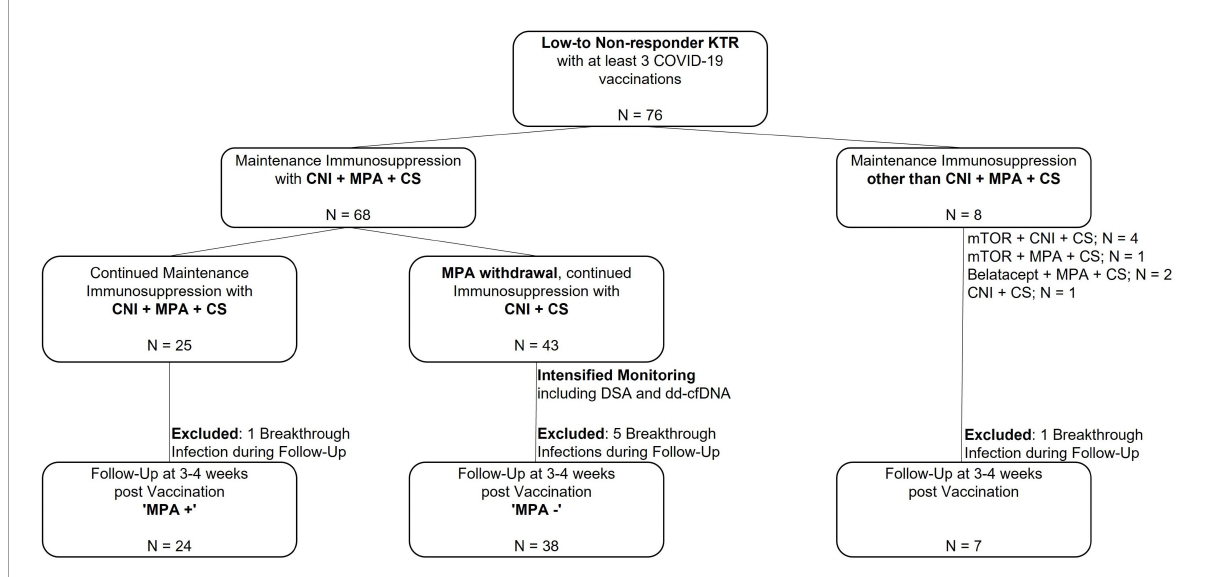
FIGURE1 Study flow chart to assess humoral responses to an additional COVID-19 vaccination in 76 non-responder kidney transplant recipients after an additional mRNA-1273 vaccine dose. A total of 76 kidney transplant recipients (KTR) with different immunosuppressive regimens with no seroconversion after at least 3 COVID-19 vaccine doses were included in this trial. Short-term withdrawal of mycophenolic acid (MPA) during vaccination was evaluated in 68 KTR with maintenance immunosuppression consisting of a calcineurin inhibitor (CNI), MPA and corticosteroids (CS). In 25 KTR, triple immunosuppressive therapy was maintained (“MPA + ”), whereas MPA was paused in 43 KTR (“MPA-”). These 43 KTR received intensified monitoring including testing for donor-specific HLA antibodies (DSA) and donor-derived cell-free DNA (dd-cfDNA) prior to and after withdrawal of MPA. In addition, humoral response was assessed in 8 KTR with immunosuppressive maintenance therapy other than CNI, MPA and CS. Breakthrough infections during the 4 weeks post vaccination surveillance period occurred in all three groups with 1 breakthrough infection in the group where maintenance immunosuppression with CNI, MPA and CS was maintained, 5 breakthrough infections in the group where MPA was withdrawn temporarily, and 1 breakthrough infection in the group with maintenance immunosuppression other than CNI, MPA and CS. Thus, follow-up for humoral response was reduced to 69 KTR. CNI, calcineurin inhibitor; CS, corticosteroids; KTR, kidney transplant recipients; MPA, mycophenolic acid; mTOR, mammalian target of rapamycin; N,